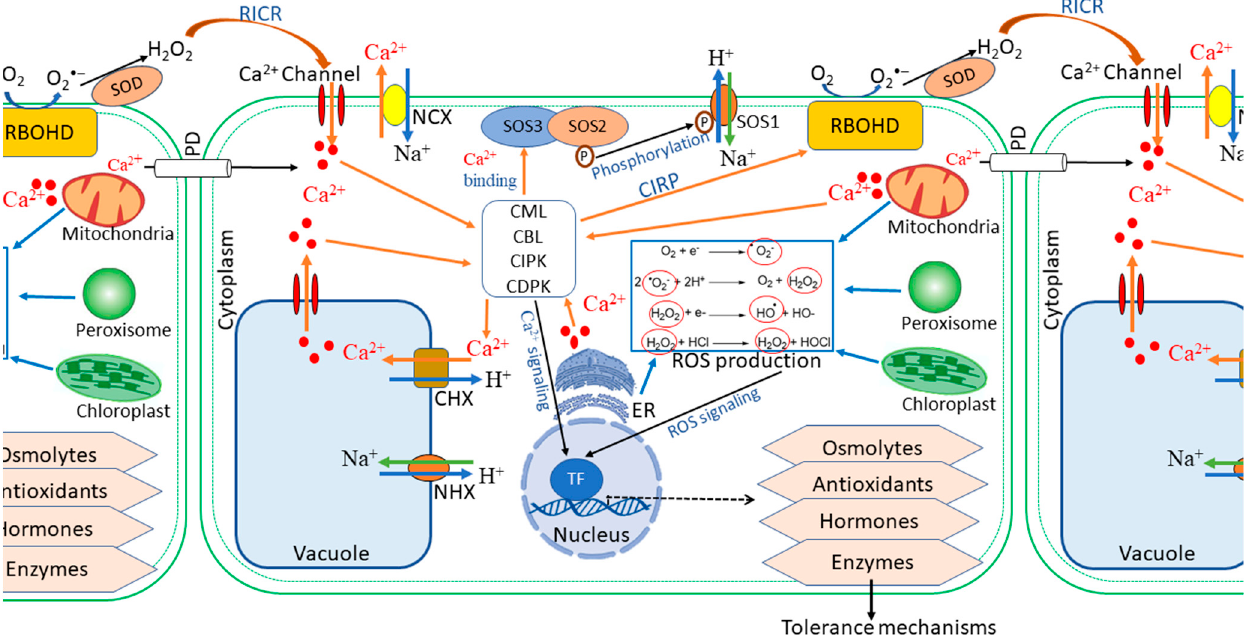
Figure 2. The interplay of reactive oxygen species (ROS) and calcium ions (Ca 2+ ) in plant signalling. ROS-induced Ca 2+ release (RICR): accumulation of ROS induces release of Ca 2+ through Ca 2+ channels; in turn, the Ca 2+ ions enhance the production of ROS through activation of the RBOHD membrane protein in the process called Ca 2+ -induced ROS production (CIRP). The superoxide produced by RBOHD is dismutated to hydrogen peroxide by the scavenging enzyme, superoxide dismutase (SOD). Activation of RBOHD proteins in initiating stress-stimulated cells results in overproduction of ROS, which are transported to adjacent cells, which, in addition to the Ca 2+ entering through the plasmodesmata (PD), trigger calcium release from reserves. The accumulated Ca 2+ activates the RBOHD to enhance ROS production. In addition, Ca 2+ activates SOS3 protein, which, in turn, interacts with SOS2 and triggers phosphorylation of SOS1 to increase Na + efflux. Ca 2+ and Na + signalling ultimately activate transcription factors for the production of stress-responsive molecules with roles in salinity tolerance mechanisms. Abbreviations: CBL, calcineurin B-like protein; CML, calmodulin-like protein; CDPK, calmodulin-dependent protein kinase; CIPK, calcineurin B-like interacting protein kinase; CHX, Ca 2+/ H + exchanger; CICR, calcium-induced calcium release; ER, endoplasmic reticulum; NCX, Na + /Ca 2+ exchanger NHX, Na + /H + exchanger; PD, plasmodesmata; RBOHD, respiratory burst oxidase homolog protein, RICR, ROS-induced Ca 2+ release; ROS, reactive oxygen species; SOS, salt overly sensitive; TF, transcription factor.